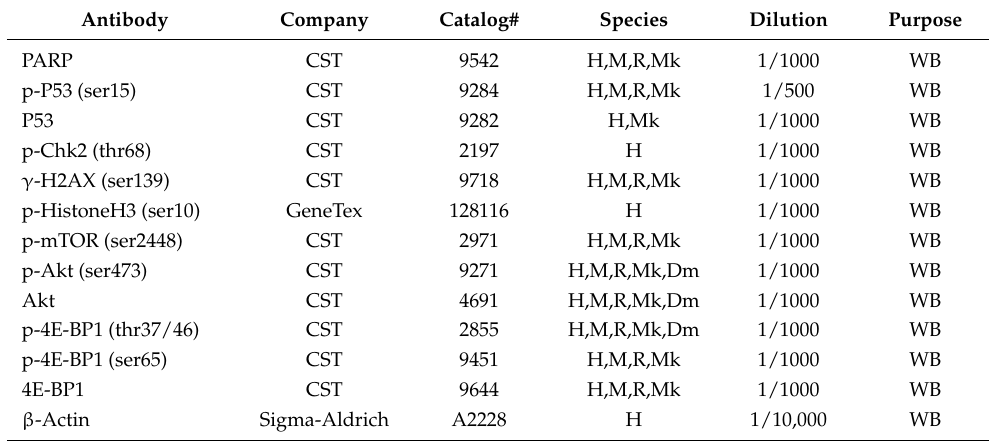
Table A3. Antibodies used in this